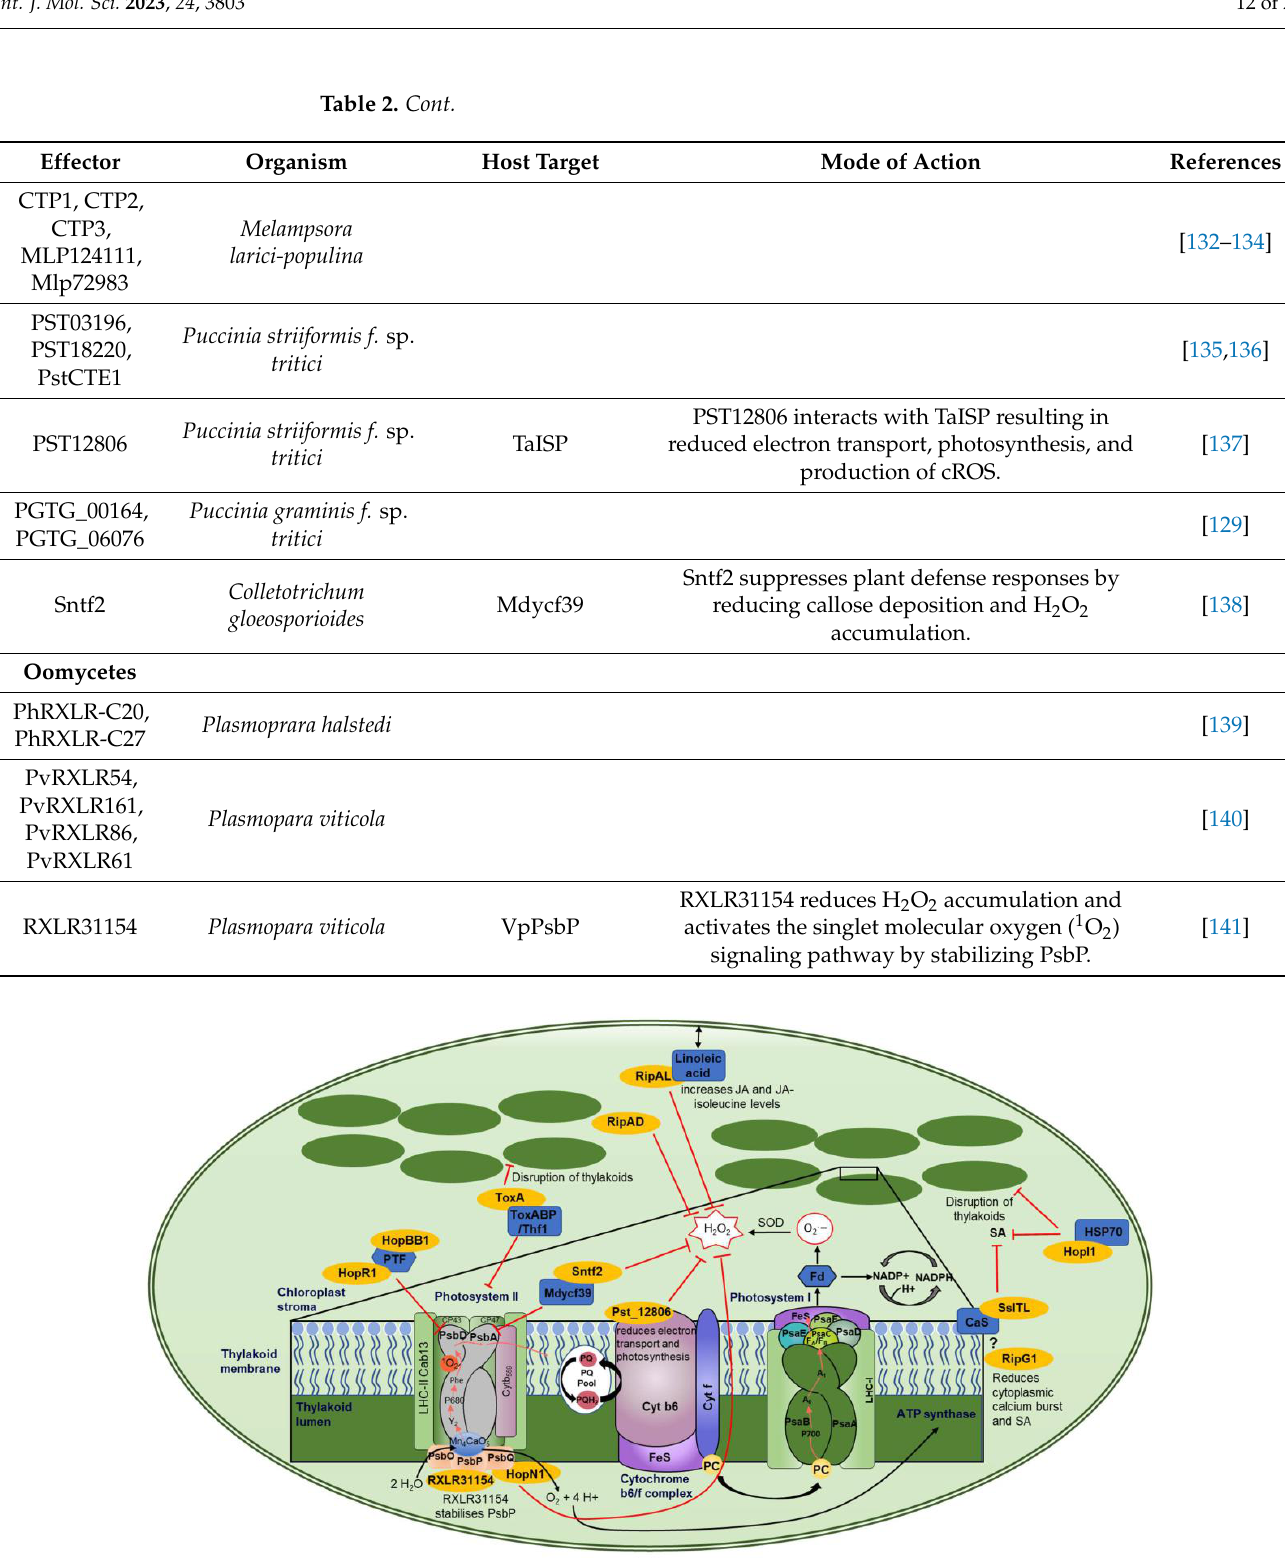
Figure 3. Chloroplast - localized effector proteins and their targets. This figure shows a representa- tive image of a chloroplast and the effector – target interactions with downstream mode of action. The enlarged box shows a schematic of the thylakoid membrane (dark green) with PSII, cytochrome b6/f complex, and PSI (various colors to better visualize subunits) along with effectors targeting various components (dark blue) of these complexes. Effectors are shown in yellow, inhibitory signaling is shown by a red line, while electron transport is shown by black arrows. The ? represents speculative interactions, and double-ended arrows represent